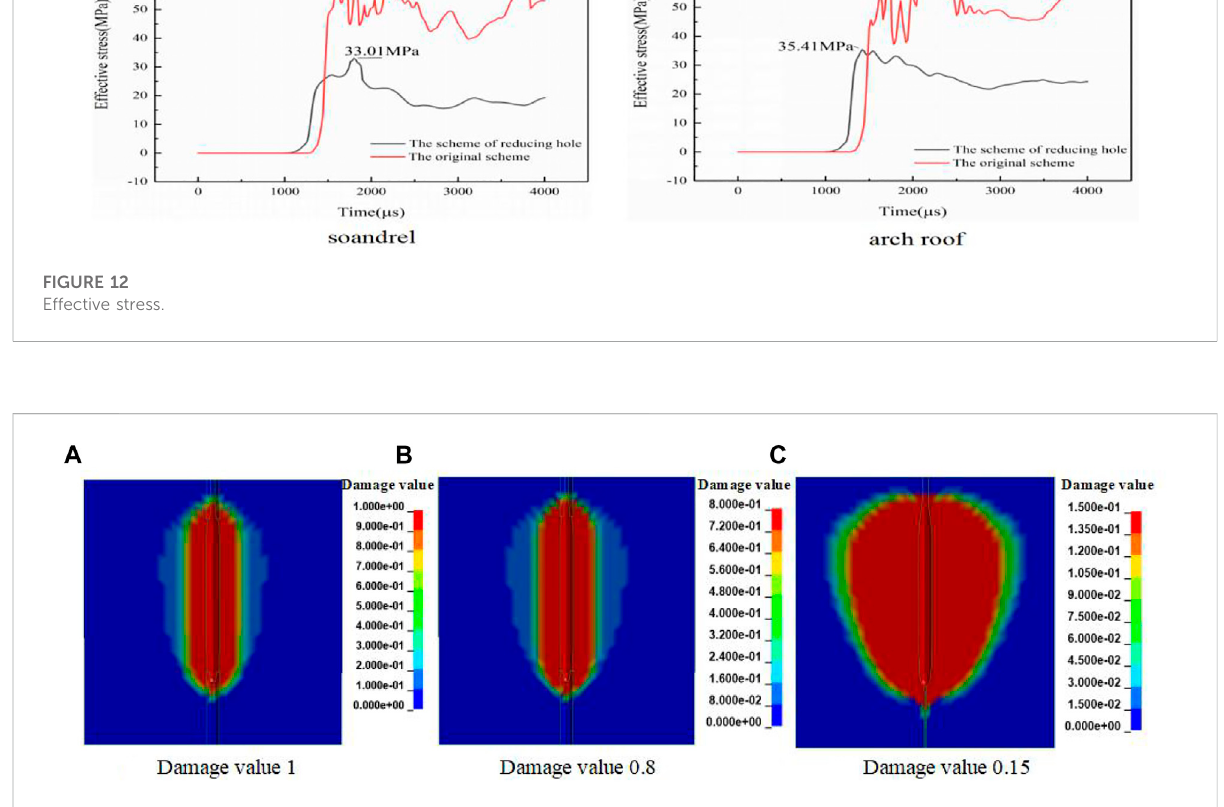
FIGURE 13 Damage area distribution of single-hole